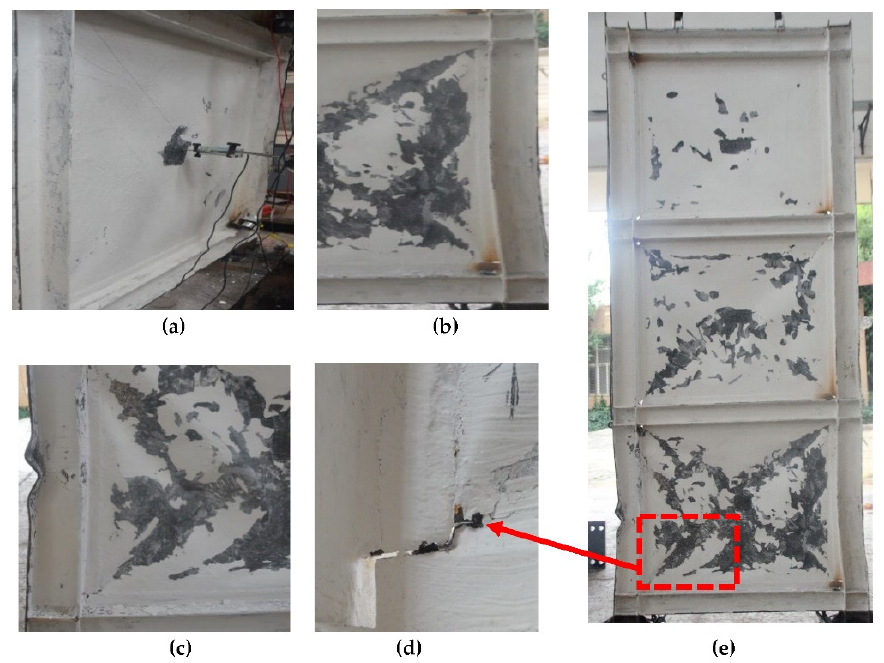
Figure 6. Details of USPSW specimen during the test: ( a ) first-floor buckling out-of-plane at cycle 7 (0.25% story drift), ( b ) fist-floor flaking of whitewash and column yielding (1.5% story drift), ( c ) first-floor column local buckling, ( d ) first-floor tearing corner of the infill plate (2.5% drift), ( e ) deformation of the specimen after the end of the test (3.3% story drift).